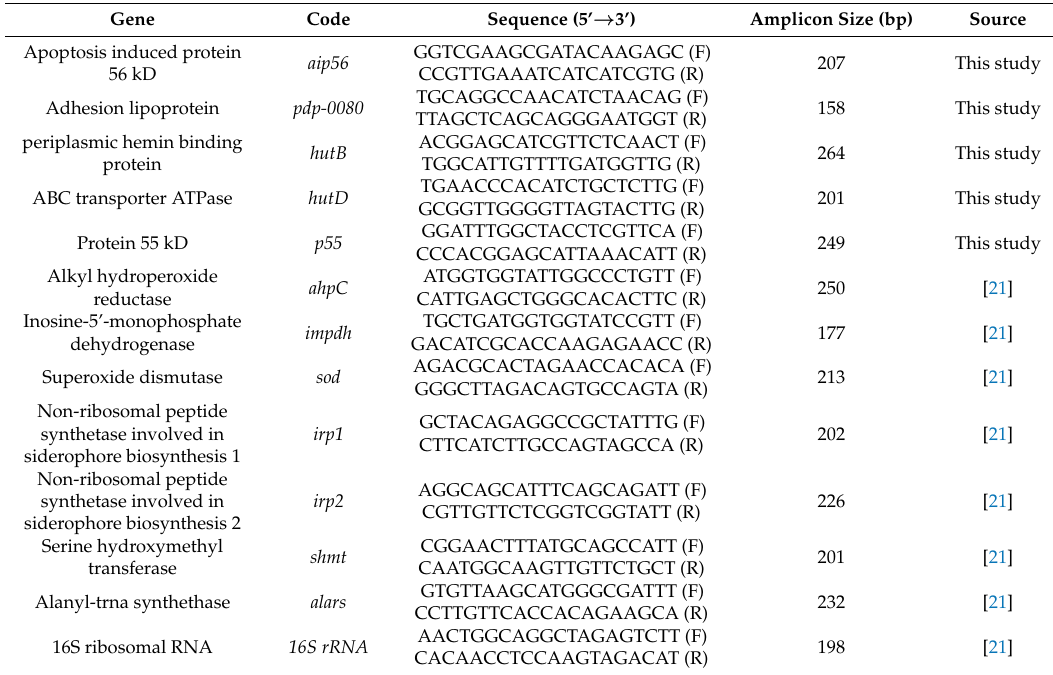
Table 1. List of primers used in the present